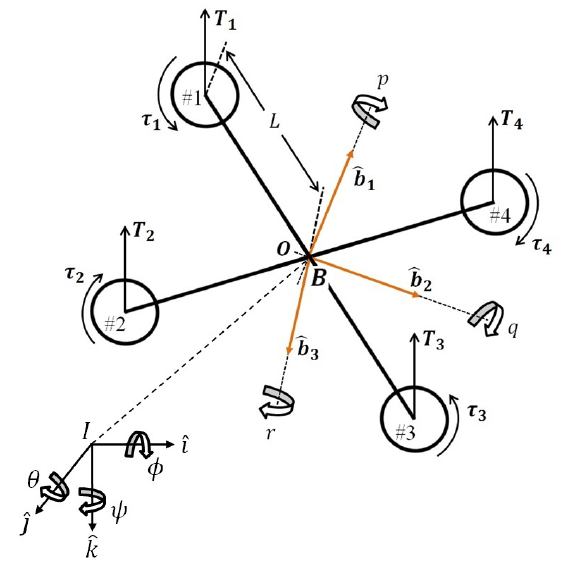
Figure 2. Thrusts, torques, quadrotor’s parameter, and reference